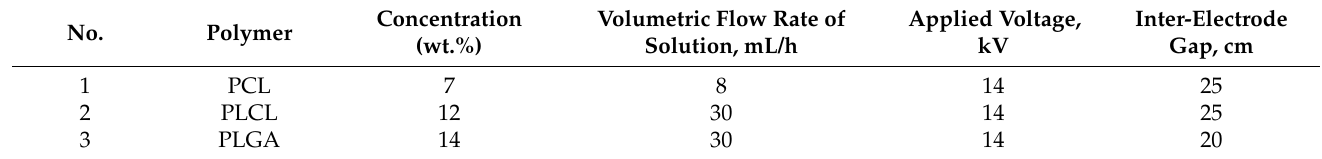
Table 1. Parameters of flat scaffold fabrication in the electric field.